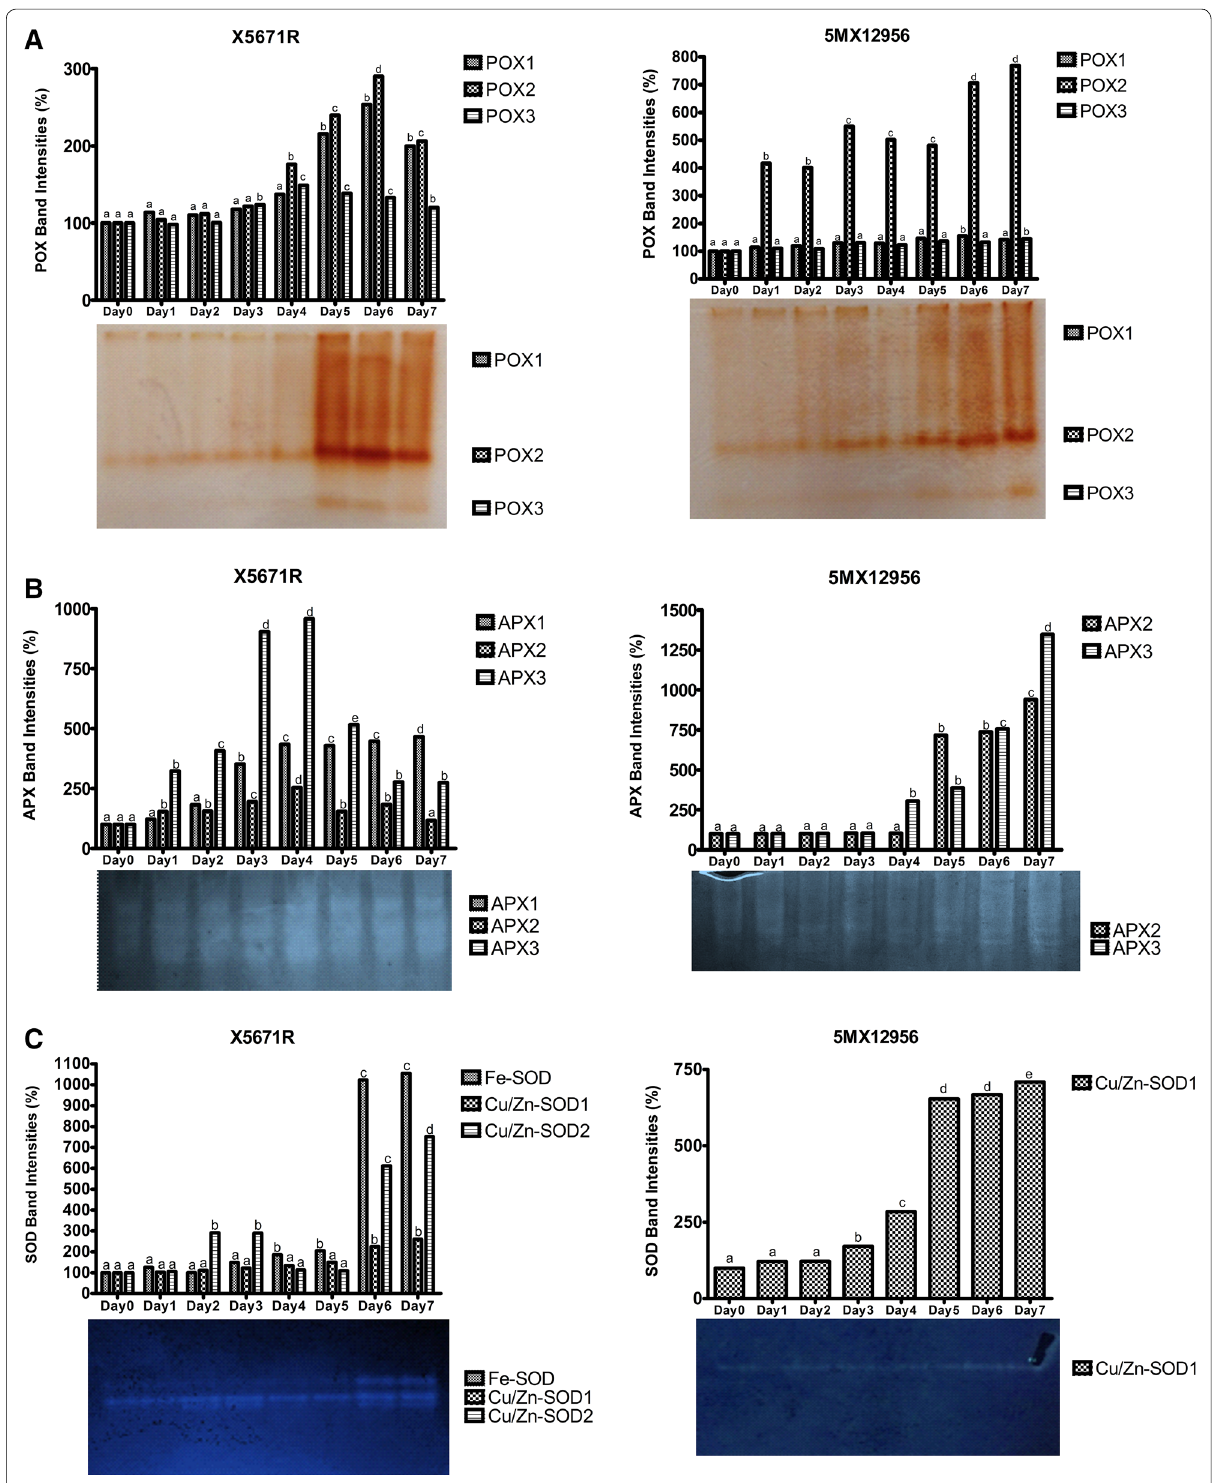
Fig. 4 Effects of 7 day drought stress on the activity staining and % changes of POX ( A ), APX ( B ) and SOD ( C ) isozymes of X5671R and 5MX12956 tomato seedlings. Samples applied to the gels contained 50 µg protein for POX and APX and 75 µg for SOD. The differentially given letters represent significance at the 0.05